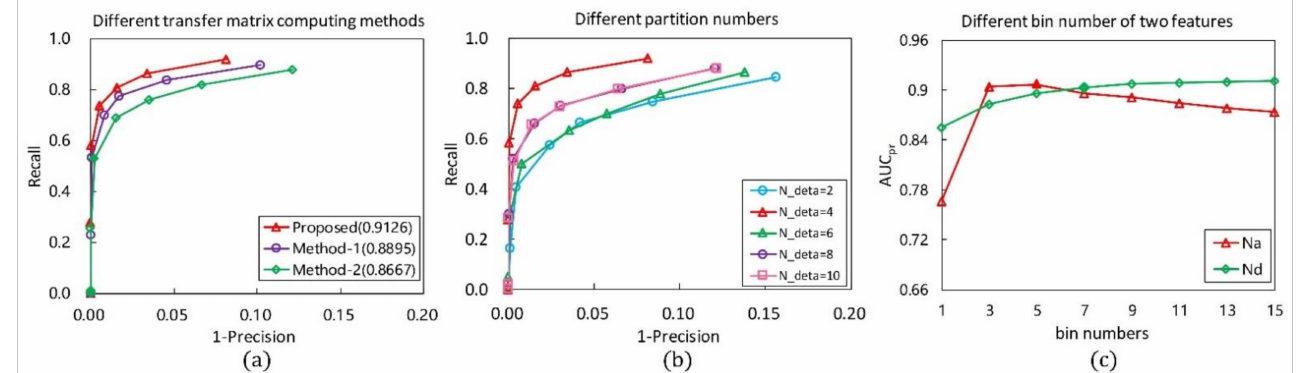
Figure 5. RPC and AUC pr results with different parameter configurations. ( a ) Different methods for computing point-pair transformation matrix, and the other parameters are separately set as r = 15 mr, N σ = 4, N a = 5, N d = 7 (the values in parentheses are the AUC pr results). ( b ) Different point-pair set partition numbers. ( c ) Different bin numbers of two types of